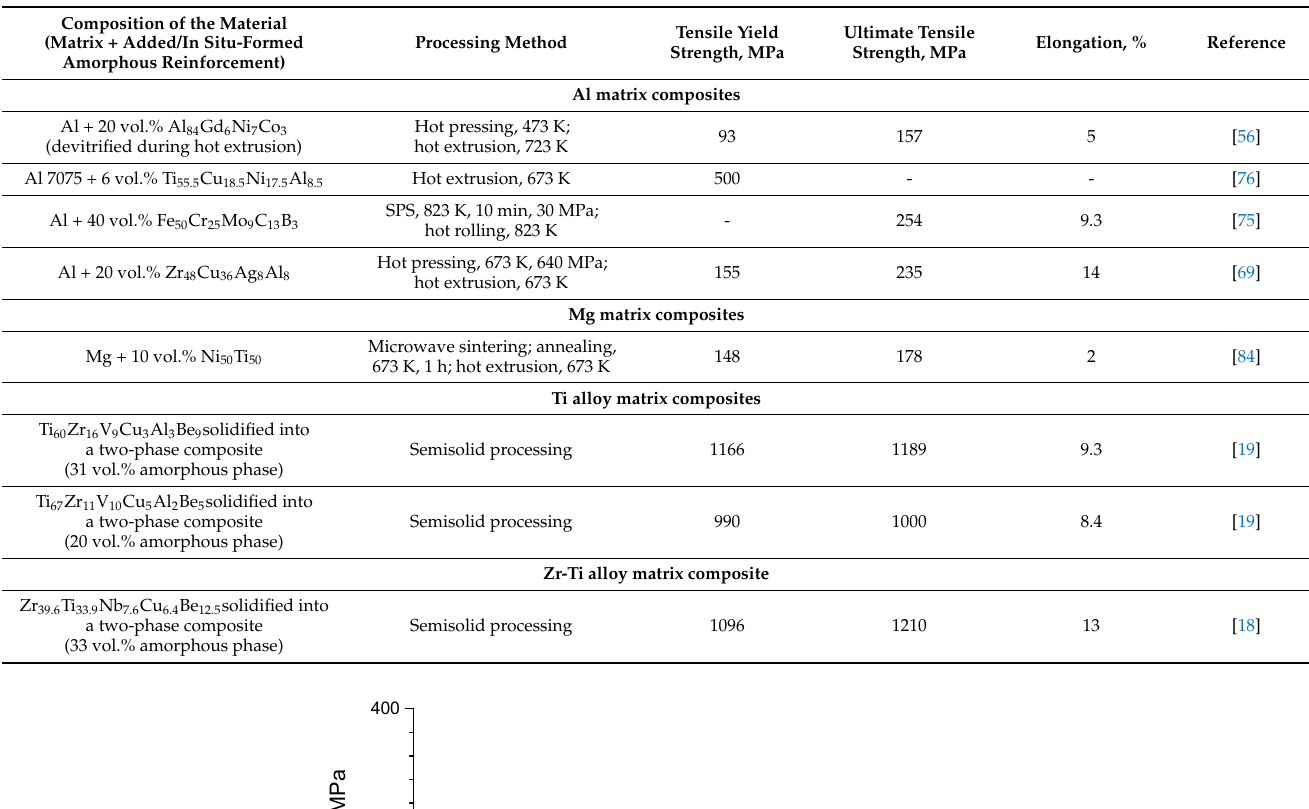
Table 5. Compressive yield strength–fracture strain combinations of several Al alloy matrix com ‐ posites reinforced with different phases (all composites were obtained via the powder metallurgy route).